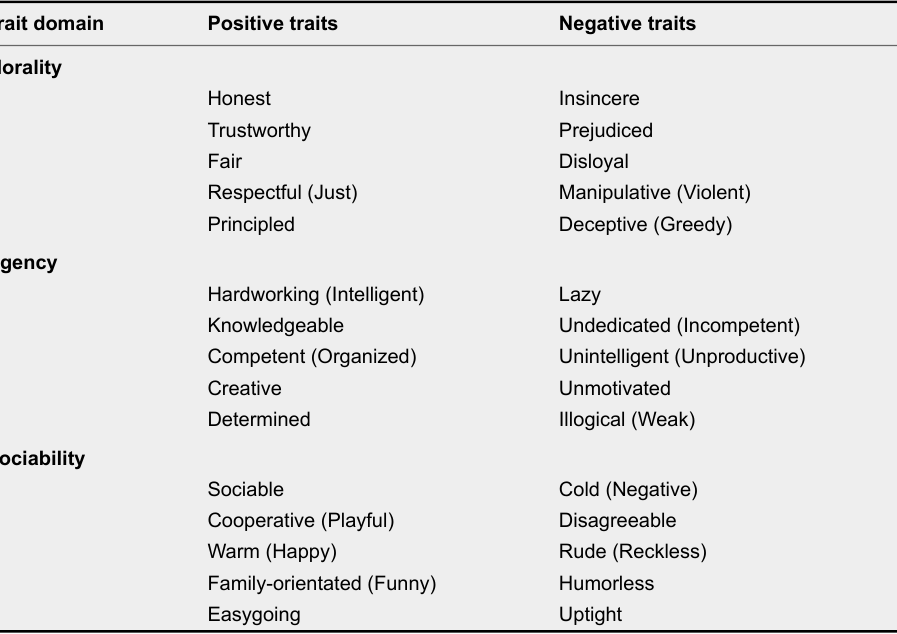
Traits Used in Studies 1 and